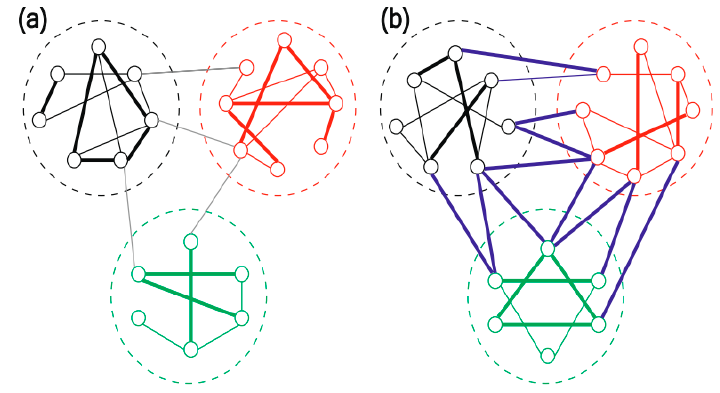
Figure 43. Schematic overview of the community-based event detection method (Ref. [152]).